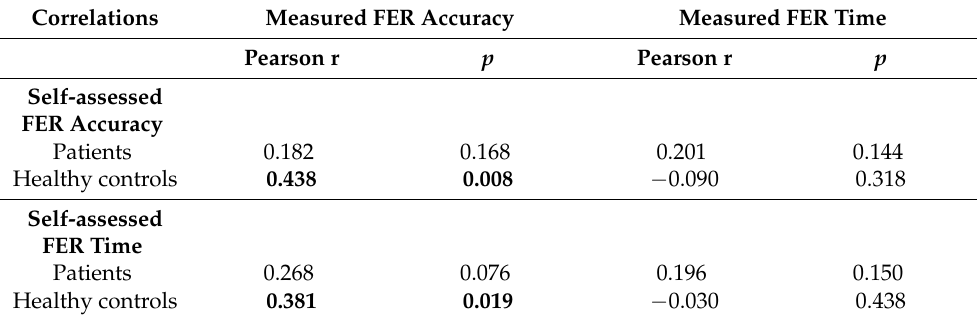
Table 6. Correlations between measured and self-assessed facial emotion recognition (FER)-